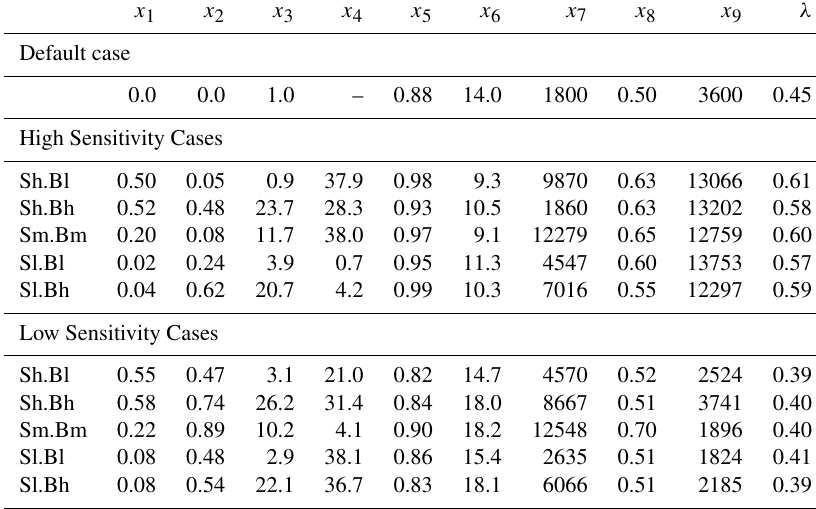
Table 2. Each row shows the input parameter values (columns 2–10), and the Cess climate sensitivity ( λ , units KWm − 2 ; column 11) predicted by the emulator for that combination of parameters. The first column denotes the strength of aerosol radiative forcing (ARF) in a case from sulfate (S) and Black Carbon (B): h = high, m = medium and l = low (defined in the text). For reference, the default parameter values in CAM4, and the associated λ , are shown toward the